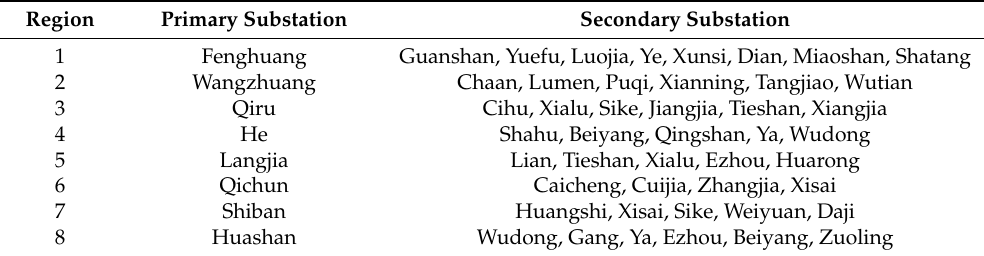
Table 4. Results of dividing into 8 regions.